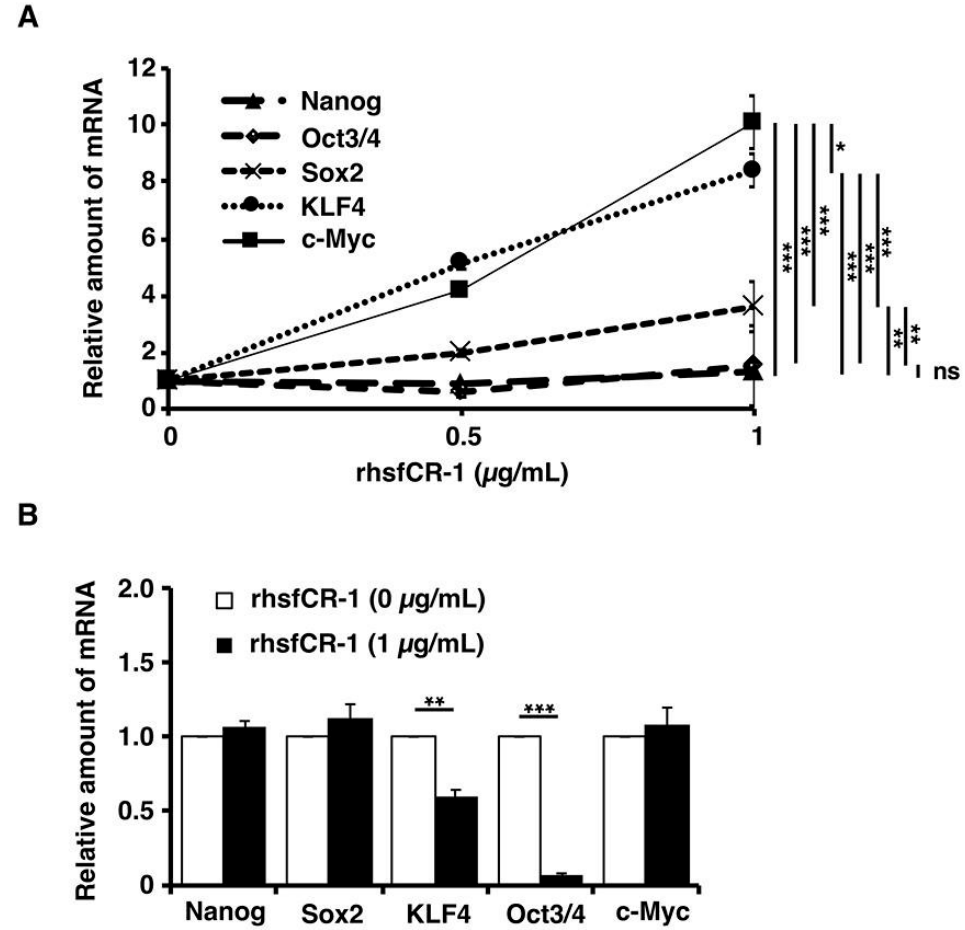
Figure 6. Evaluation of the expression of the stemness markers, Nanog, Oct3/4, Sox2, Klf4 and c-Myc, in miPS-LLCcm cells in adherent culture ( A ) after 24 h of treatment with rhsfCR-1 and in spheres under non-adherent condition ( B ) of miPS-LLCcm cells treated with rhsfCR-1 by rt-qPCR. GAPDH was used as endogenous control and each bar represent mean ± SD of three data points. Two-way ANOVA ( A ) with multiple comparison and Student’s t -test ( B ) were conducted to analysis the level of significance (* p < 0.05; ** p < 0.01; *** p < 0.001; ns, not significant).